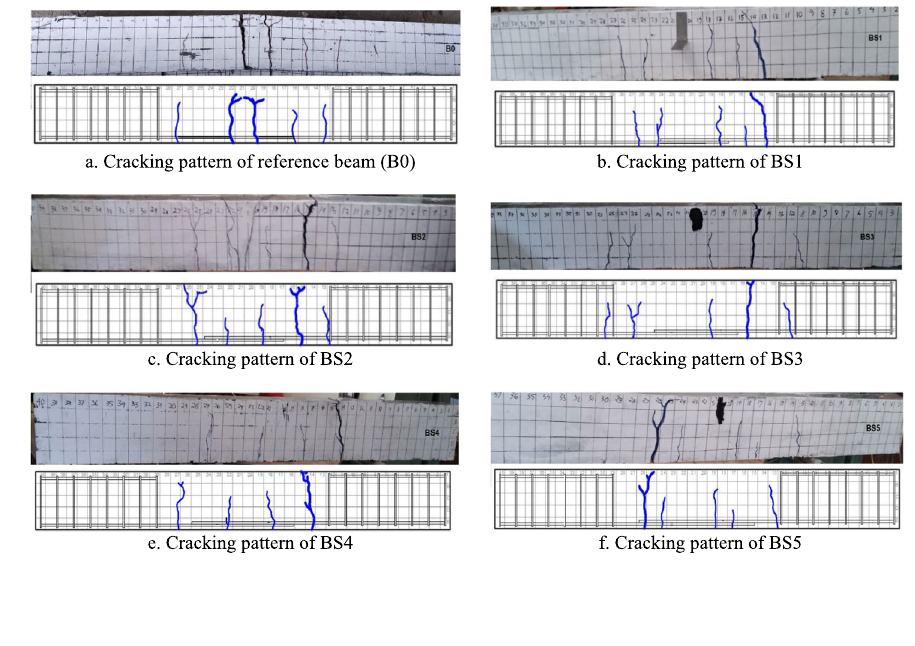
Fig. 4 Comparison of load– deflection behavior of beam with continuous bar (B0) and spliced bars